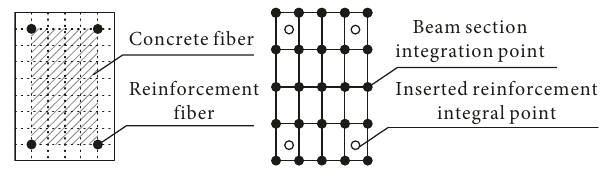
Figure 13: Section of fiber-beam